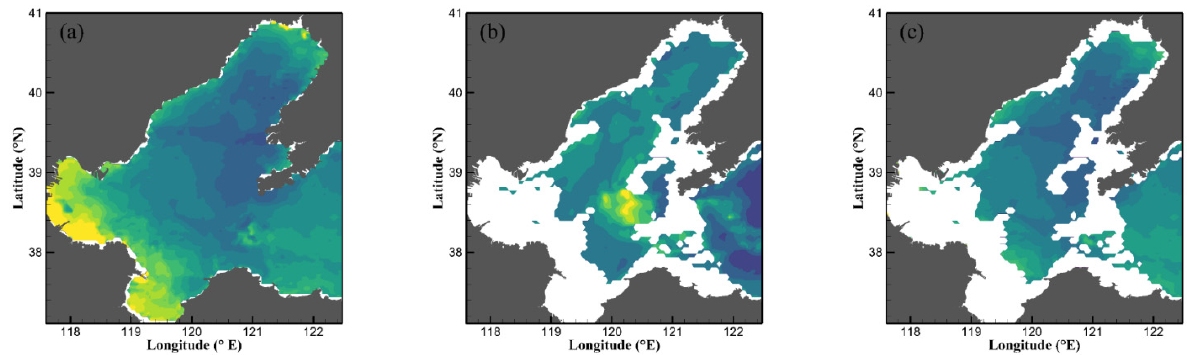
Figure 3. Schematic diagram of the construction process of Dataset2: ( a ) Original SST Data, ( b ) Original chl-a Data, and ( c ) Constructed SST Missing Data. (The gray area represents land, the white area represents missing data points, and the green area represents valid data points).